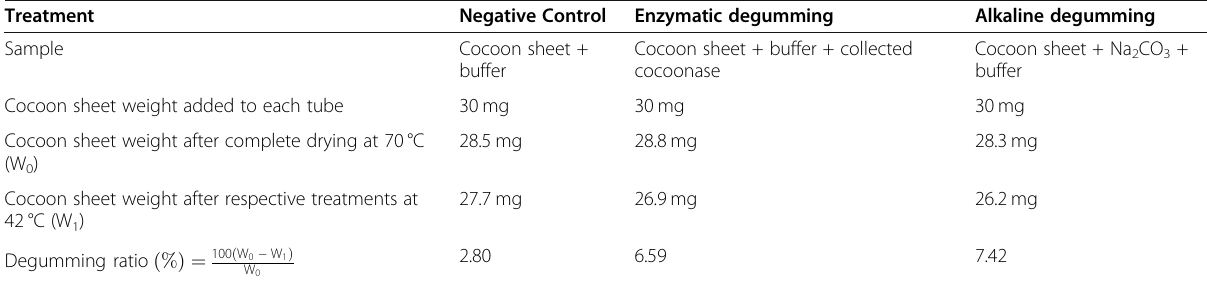
proteins [62, 77]. Also, COFACTOR, a protein func- tion prediction webserver, predicts EC numbers and ligand-binding sites by using structural properties of proteins [62]. Varying ligand-binding site residues as well as functional template for cocoonase and sericin with a high confidence scores (C-score = 0.95 and C- score = 0.09, respectively) have been predicted, where high C-score (0 – 1) indicated that deduced structures (Fig. 6 a and b) were stable. COFACTOR-based pro- tein function prediction by finding Enzyme Commis- sion number (EC) and ligand-binding sites has also been described [77]. For cocoonase, a template PDB ID:1z8gA with EC number 3.4.21.106 (a hepsin be- longing to peptidase family S1A), active-site residues (45, 88, 180, 182, 183, and 197), and C-score of 0.75 Table 1 Degumming effect of cocoonase on cocoon sheet for 1 h at 42 °C Treatment Negative Control Alkaline degumming Sample Cocoon sheet + Cocoon sheet + buffer + collected buffer cocoonase Cocoon sheet weight added to each tube Cocoon sheet weight after complete drying at 70 °C (W 0 ) Cocoon sheet weight after respective treatments at 42 °C (W 1